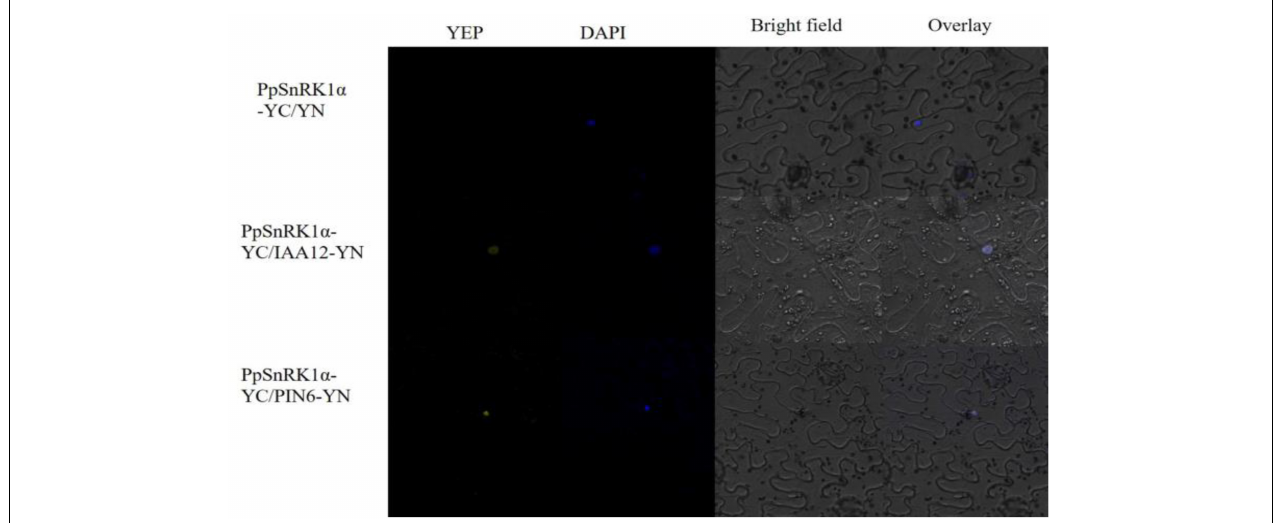
FIGURE 9 | Results of the bimolecular fluorescence complementation (BiFC) assay showing the interaction between PpSnRK1 α and IAA12/PIN6. The protein complex was visualized in tobacco leaf epidermal cells. Results are from one representative experiment out of three independent